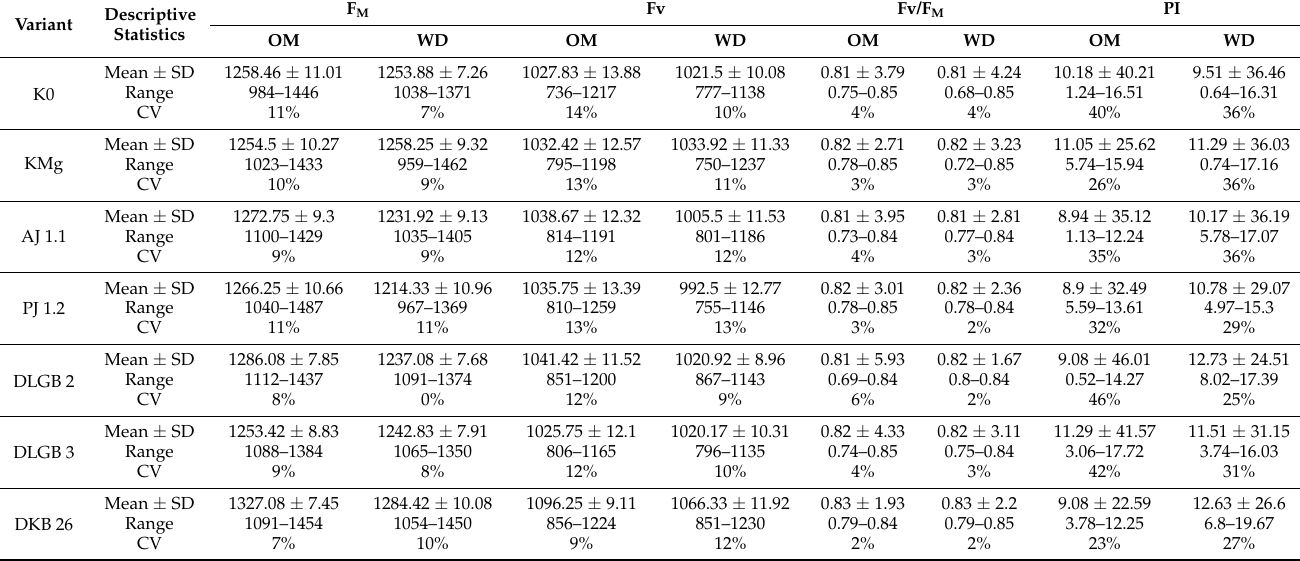
Table 3. Descriptive statistics